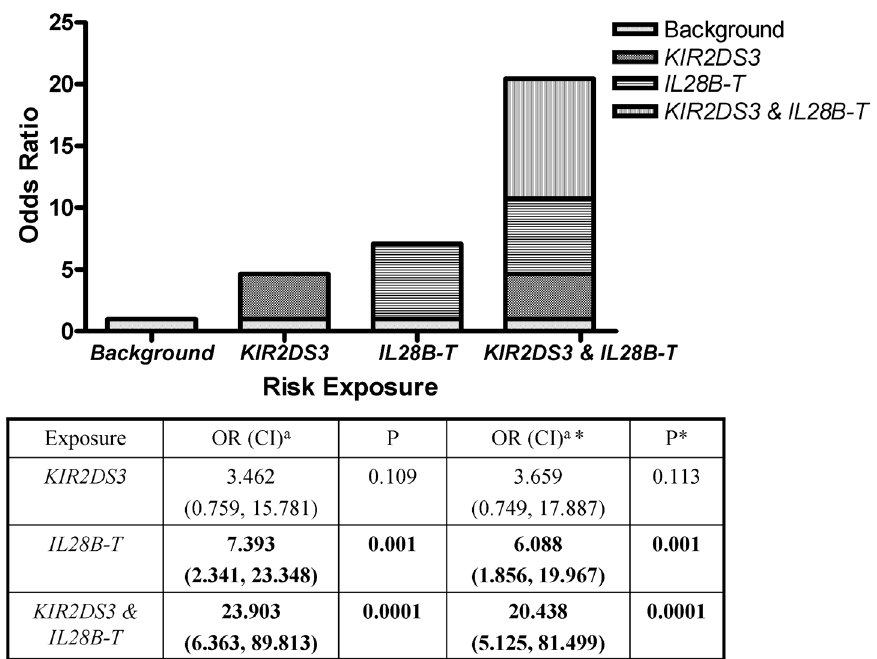
Figure 1. The presence of both KIR2DS3 and IL28B-T alleles synergise to increase the odds of HCV treatment failure. ORs for KIR2DS3 alone, IL28B-T carriers (CT or TT) alone, and KIR2DS3 with IL28B-T compared with neither risk factor present were calculated from multinominal logisitic regression. The contribution of individual and combined risk factors to the ORs is graphically represented in the bar chart. Positive OR indicates an association with increased odds of treatment failure. a Odds ratio (95% confidence interval). * adjusted OR including HCV genotype and HAART as co-variates.